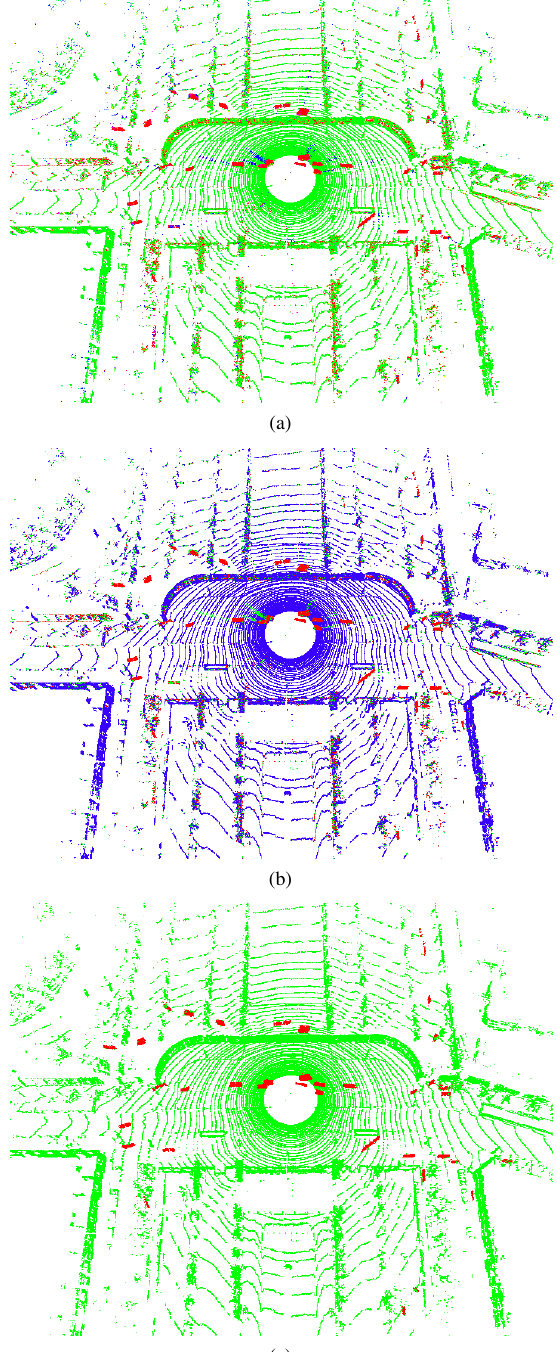
Figure 8. Moving object detection from a mobile laser